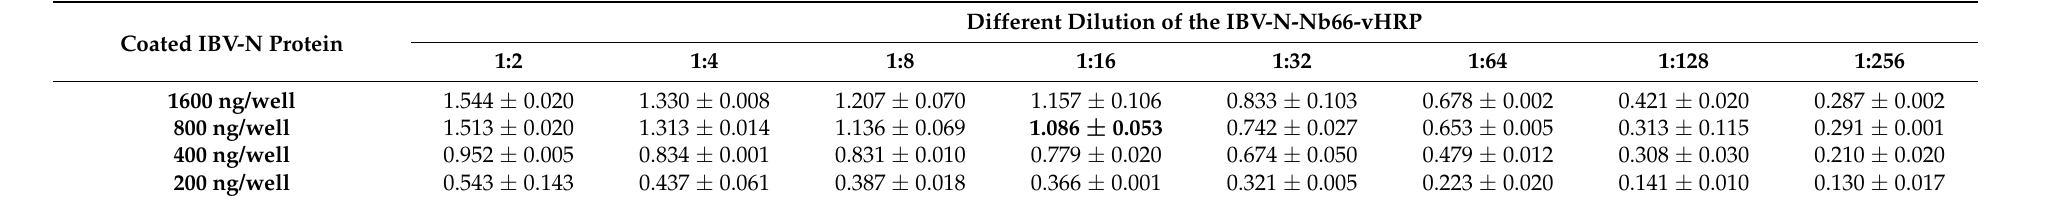
Table 2. Determination of the optimal coating amount of IBV-N protein and the optimal dilution of IBV-N-Nb66-vHRP fusion